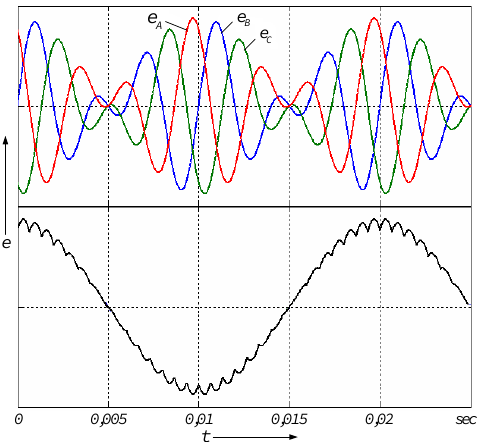
Figure 4. EMF waveforms of armature windings of generator and the output voltage envelope of